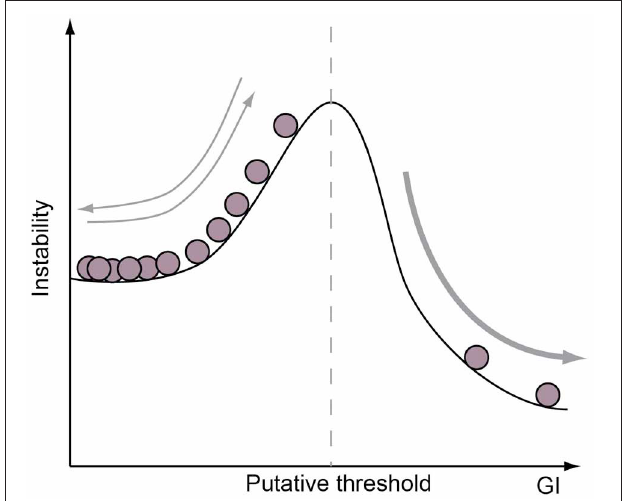
FIGURE 4 | Neurogenic program is a limiting factor on GI potential. A cartoon illustrating the concept that the range of GI achievable is determined by the cell-biological features of a species neurogenic program. For example, species without proliferative progenitor-types in the basal compartment may be limited to GIs below a certain value (dotted vertical line), whereas species with such a progenitor-type are only constrained by a lower GI limit. Note that if a range of GI values may be achieved without adapting cell-biological features of the neurogenic period, then species in the lower GI range are likely to show frequent evolutionary increases and decreases in